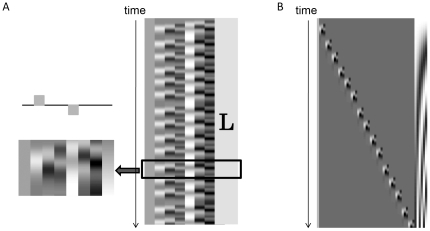
Design matrices for real-time processing and off-line processing.
A, The design matrix for real-time sliding-window GLM analysis. The time window was 80 data points wide. The matrix consisted of one constant column, three columns for task and rest phases, respectively, and one linear term (L). Task-related signal changes were estimated as a beta value, comparing task data with resting data. B, The design matrix for off-line task-by-task GLM analysis. The matrix consisted of a constant column, columns for each task, and a high-pass filter with a cut-off frequency of 0.0125 Hz.